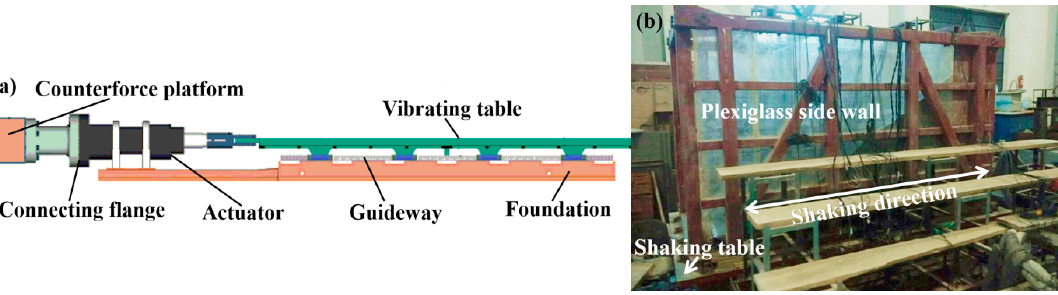
( b ) Figure 3. Diagrams of shaking table and rigid model box. ( a ) Shaking table; ( b ) rigid model box.